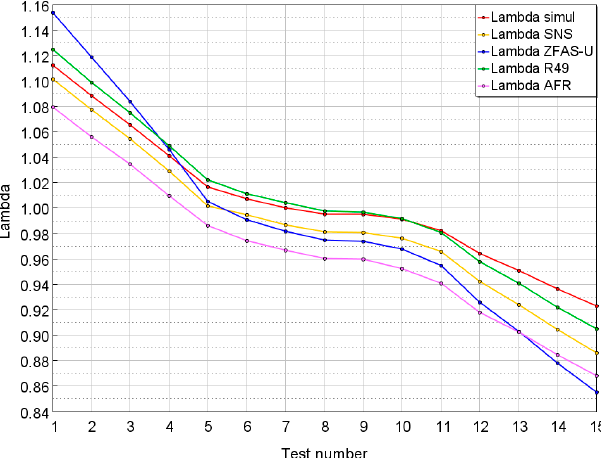
Figure 2. Comparison of λ values calculated with different formulations at 1900 RPM (100%) load. On the y -axis, the average value of λ is shown for each of the 15 conditions tested. In red: λ from GT-Suite; in yellow: measured λ from the Smart NO x Sensor (SNS); in blue: measured λ from the Universal Lambda Sensor (ZFAS-U); in green: λ derived from the R49 regulation; in pink: λ from air/fuel ratio and stoichiometric dosage.